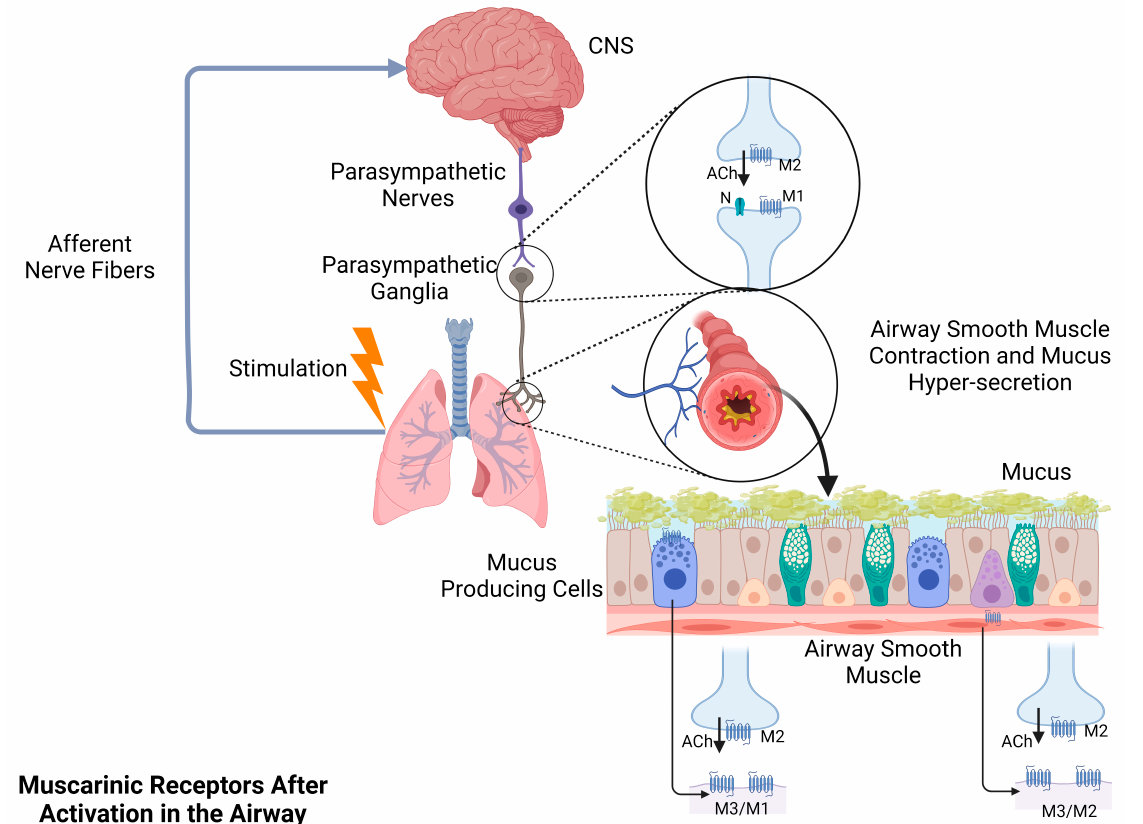
Figure 2. Cholinergic receptors in the regulation of airway smooth muscle contraction and mucus secretion. Abbreviations: M, muscarinic acetylcholine receptors; N, nicotinic acetylcholine receptors; ACh, acetylcholine; CNS, central nervous system. Figure created with BioRender.com (accessed on December 30th, 2022).